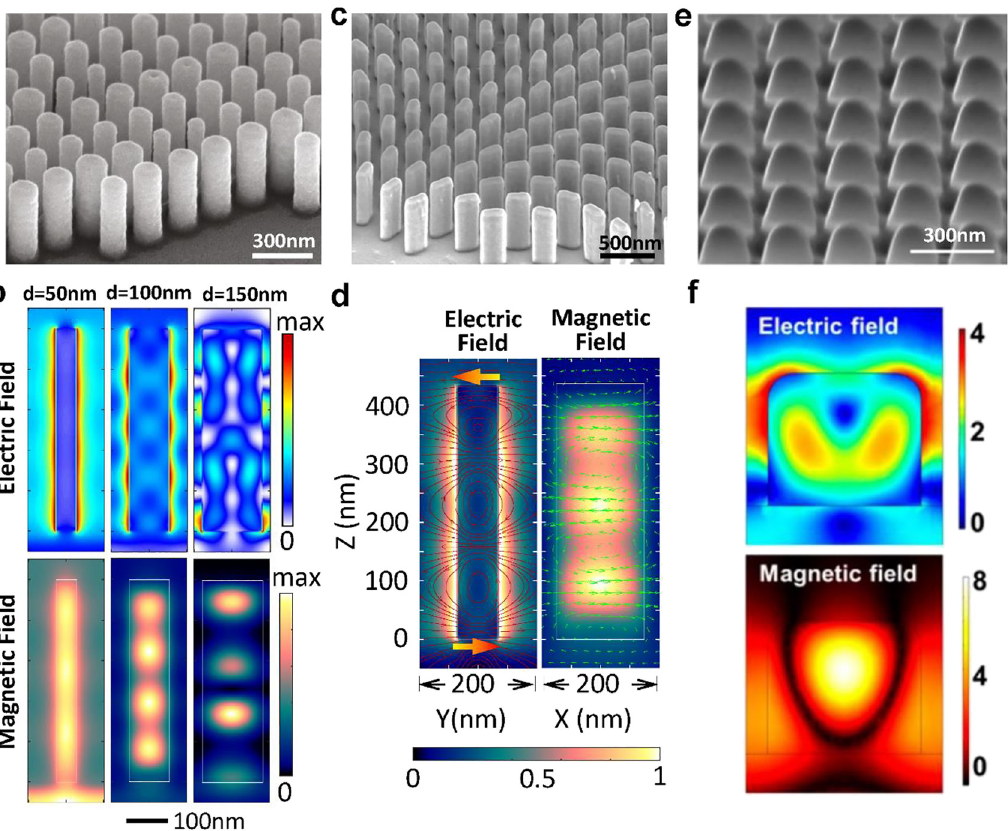
Figure 5: (a and b) SEM image (a) of HfO 2 -based waveguide metasurfaces and the electromagnetic nanomodes (b) resonating in the nanopillarswithdifferentdiametersrangingfrom d =50to150nm.Zhangetal.[106].Authorcopyright.(candd)SEMimage(c)ofNb 2 O 5 -based geometric metasurfaces and the antiferromagnetic resonances (d) in the nanostructures under the illumination of y -polarized light. Huang etal.[109].©2019,WILEY ‐